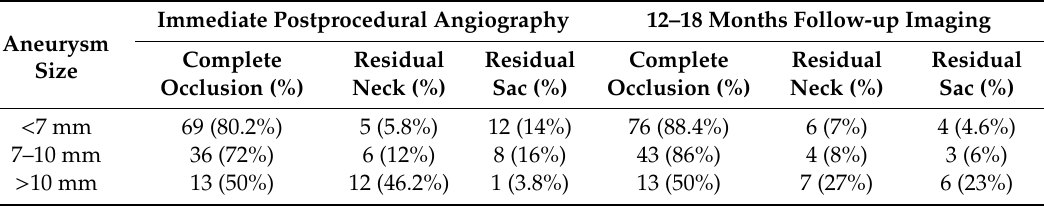
Table 3. Aneurysm occlusion rate stratified by aneurysm